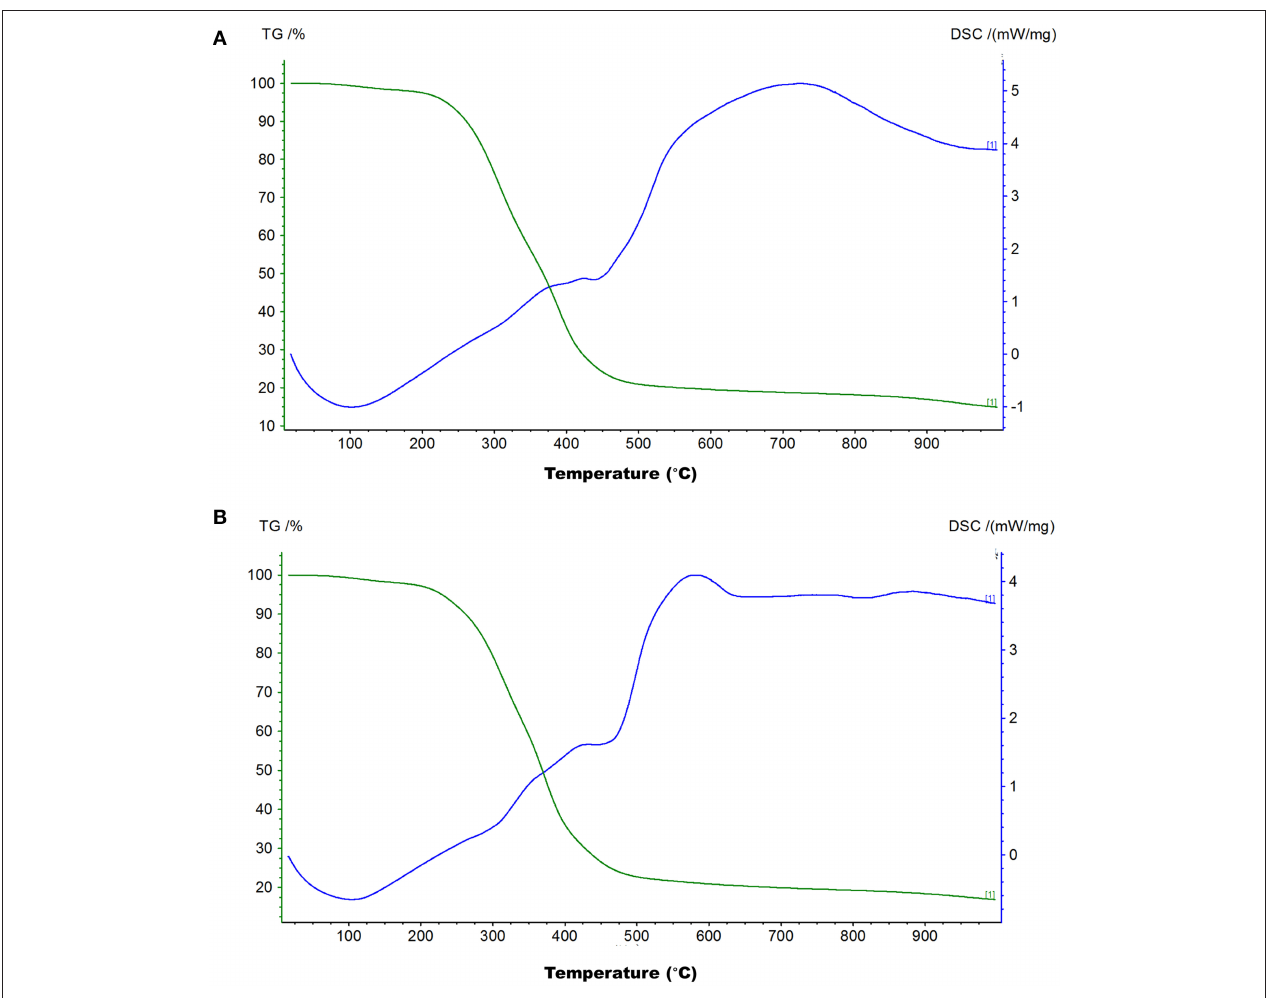
FIGURE 4 | Thermogravimetry and differential scanning calorimetry (TG-DSC) curves of melanins isolated from black sesame (A) and brown sesame (B)